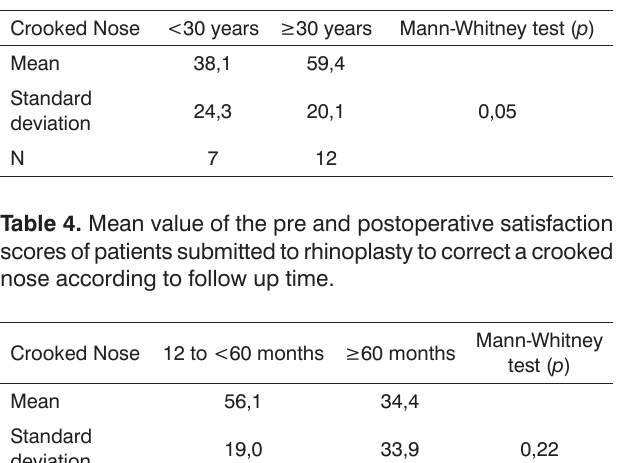
Table 3. Mean difference of the pre and postoperative scores of those patients submitted to rhinoplasty in order to correct a crooked nose, according to age.